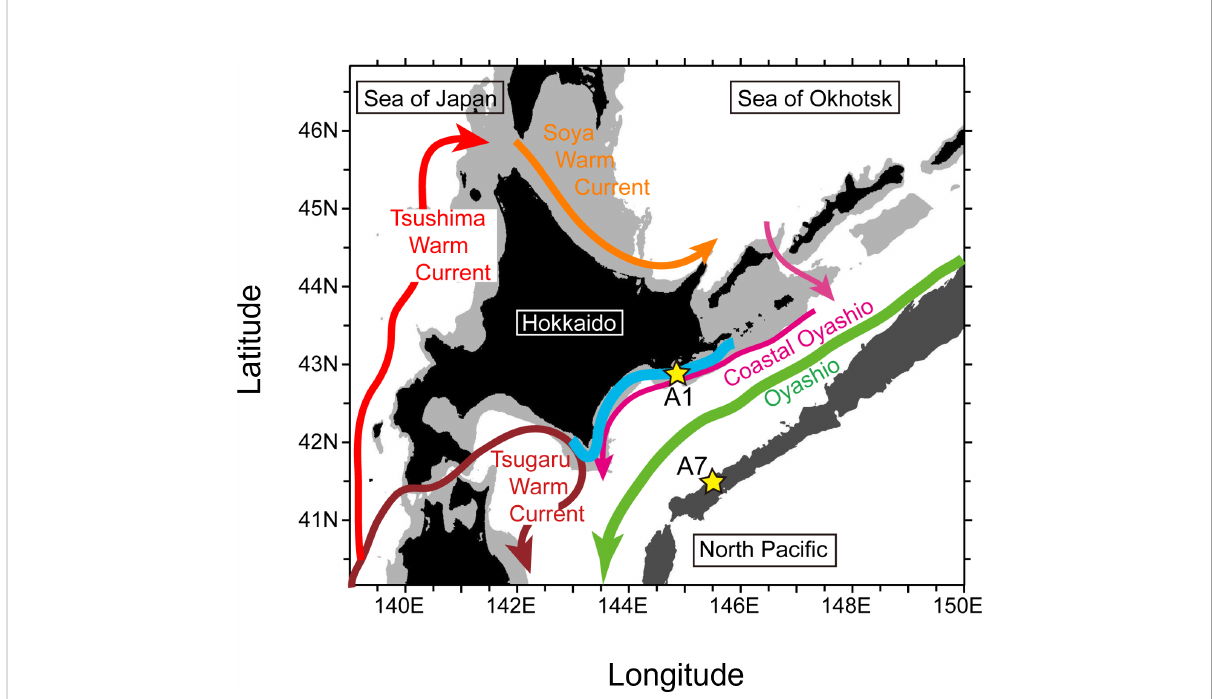
FIGURE 1 Location of Stns. A1 and A7 (yellow stars) and schematic of surface ocean currents (arrows) around Hokkaido during summer − autumn. Water depths ≥ 6500 m (i.e., trenches) and < 200 m (i.e., continental shelf) are shown by dark and light gray shading, respectively. The bold, light-blue line roughly indicates coastal waters where fi sheries experienced devastating damages that were attributable to harmful algal blooms after mid- September